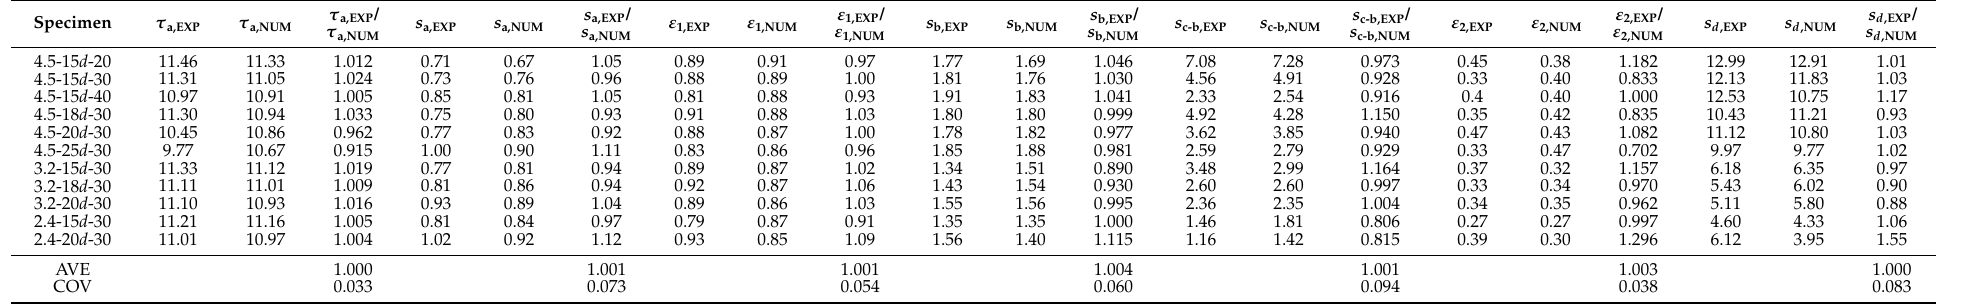
Table 2. Comparison between measured and predicted